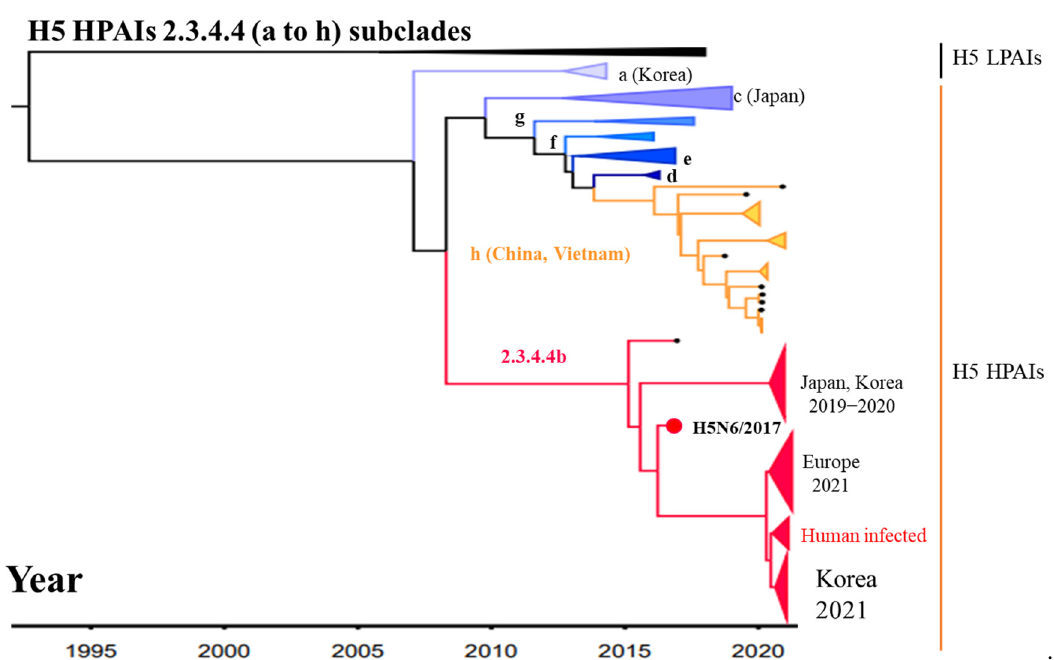
Figure 10. Distribution of the H5 HPAIVs 2.3.4.4 subclades (a to h) in Korea and other world regions in 2014–2021. A Bayesian time-resolved phylogenetic tree was obtained for the hemagglutinin gene segment using BEAST 1.8.4. Isolate sequences were downloaded from the Global Initiative on Sharing Avian Influenza Data database (http://www.gisaid.org; accessed on 25 December 2021). the red circle indicates the A/Anas platyrhynchos/Korea/W612/2017(H5N6) 2.3.4.4b gene section used as the immunogenic antigen in the present study.